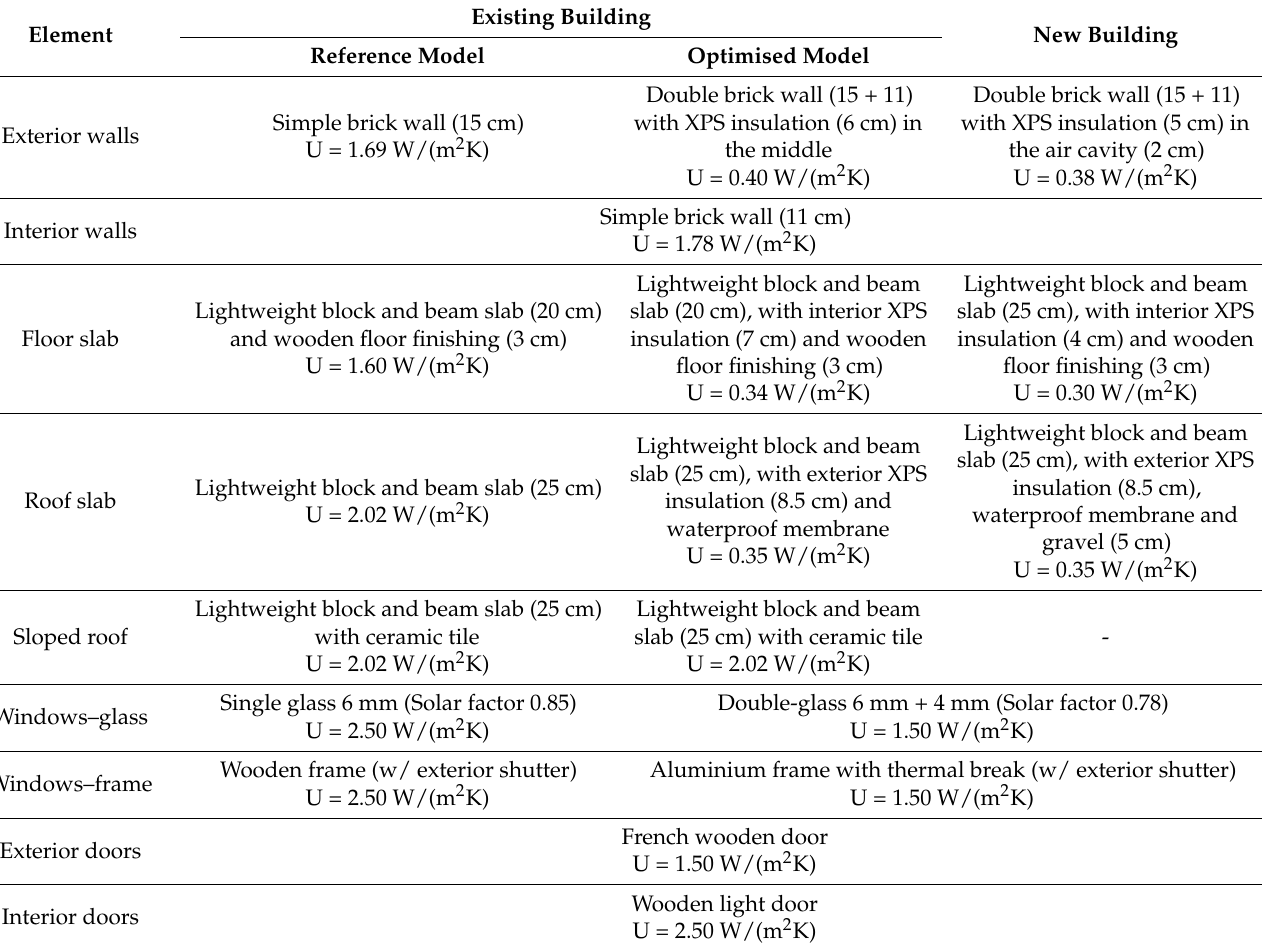
Table 2. Construction solutions and